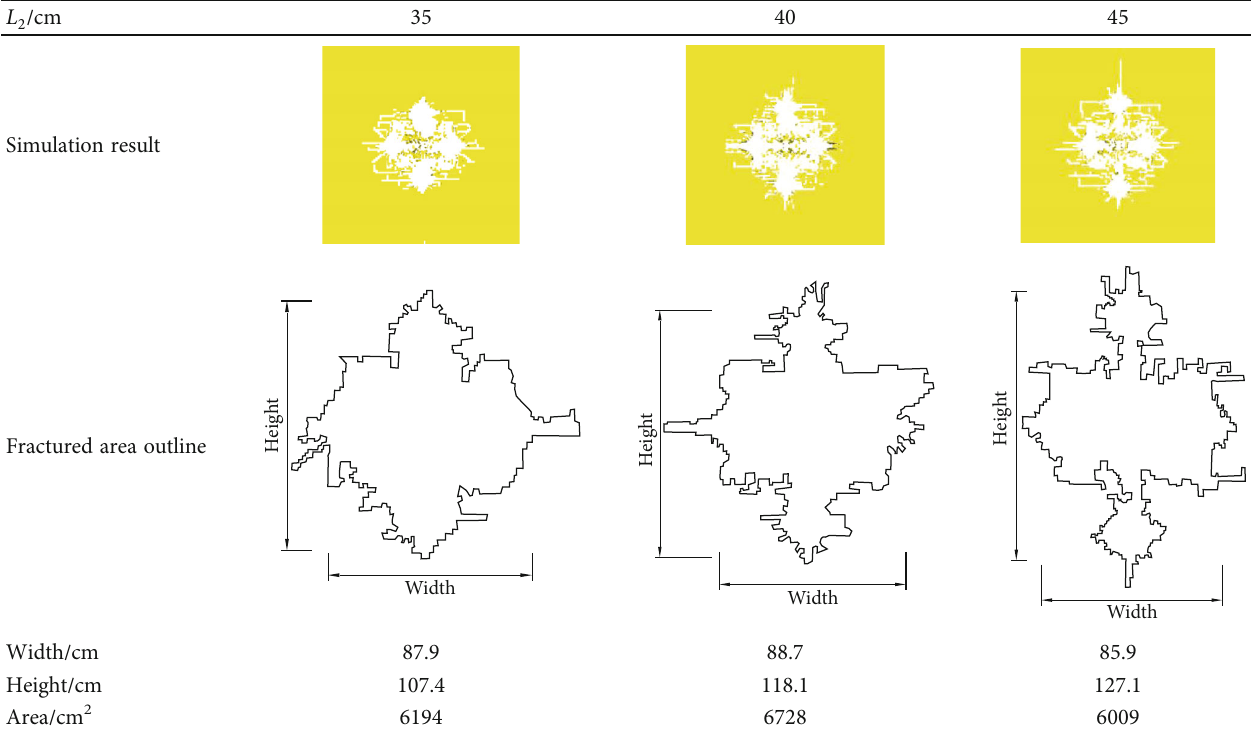
Table 7: Rock failure range at the distance between the second blast hole and the empty